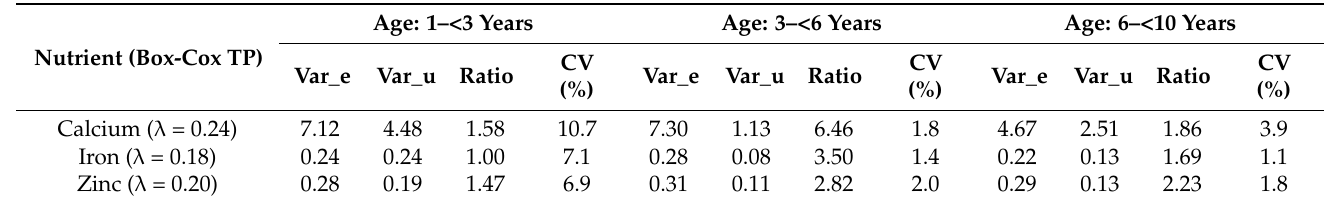
Table 2. Within-person and between-person variance, ratio of these two parameters and the coefficient of variation for usual intake of calcium, iron and zinc, by age